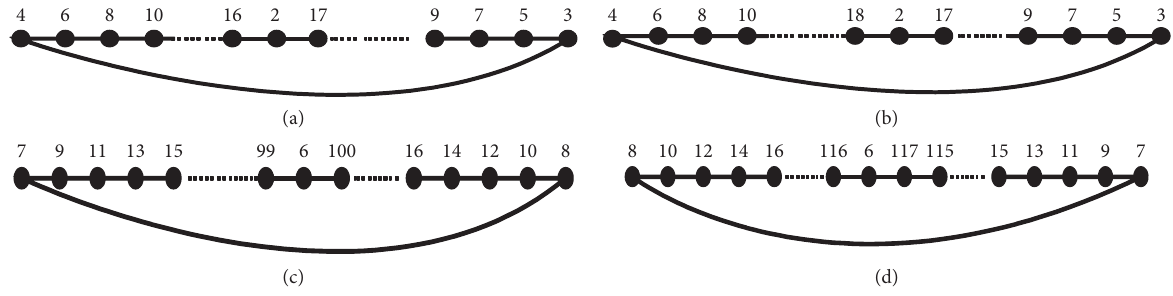
Figure 2: The radio mean square number of cycles C